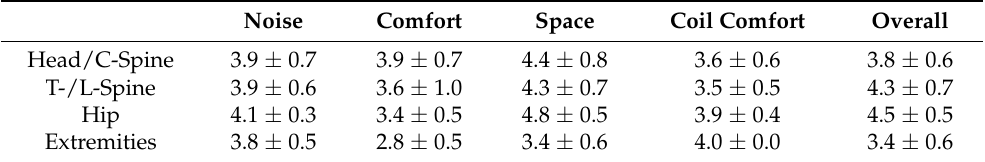
Table 3. Results of the patient evaluation with regard to noise, comfort, space perception, coil comfort and the overall experience (mean ± standard deviation) depending on the examined body region.